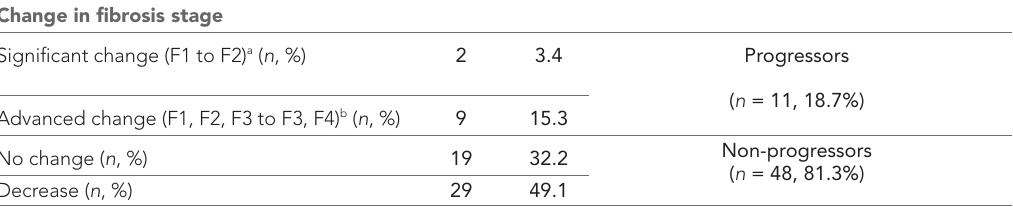
Table 1 Summary of patient VCTE fibrosis stage changes between baseline and follow- up scans ( n =